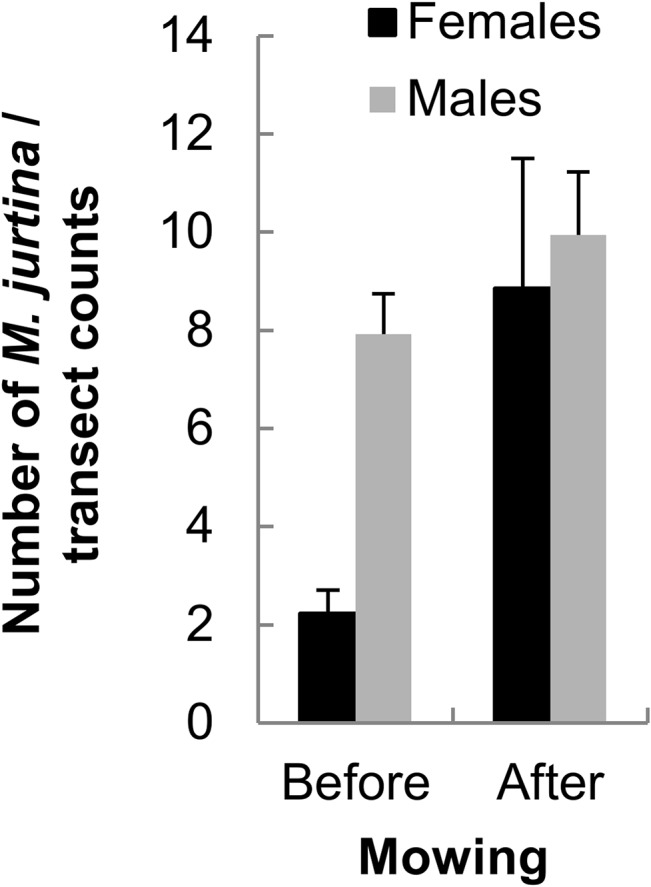
Increase in M. jurtina after mowing.Mean number (± SE) of M. jurtina recorded during transect counts in the refuge zone before and after mowing. Mixed model: Date: F1, 180 = 13.58, P = 0.0003, Date2: F1, 196 = 24.38, P < 0.0001, Mowing: F1, 26.2 = 6.04, P = 0.0209, Sex: F1, 169 = 65.7, P < 0.0001, Mowing x Sex: F1, 169 = 11.04, P = 0.0011. Ntotal = 1474 (562 females and 912 males).